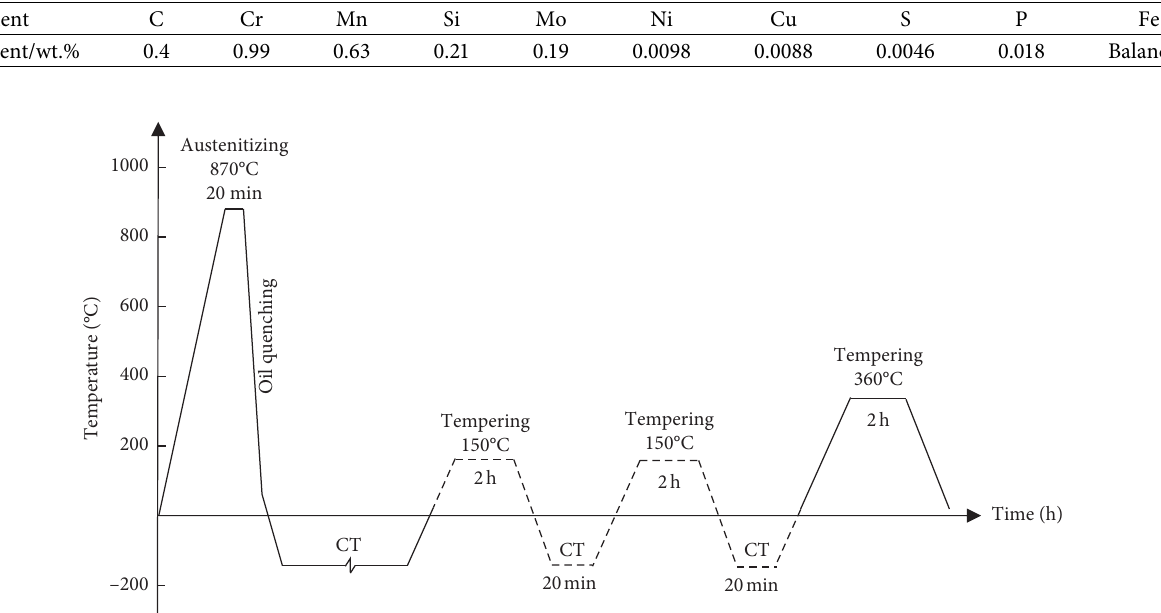
Table 1: Chemical composition of raw 42CrMo steel.